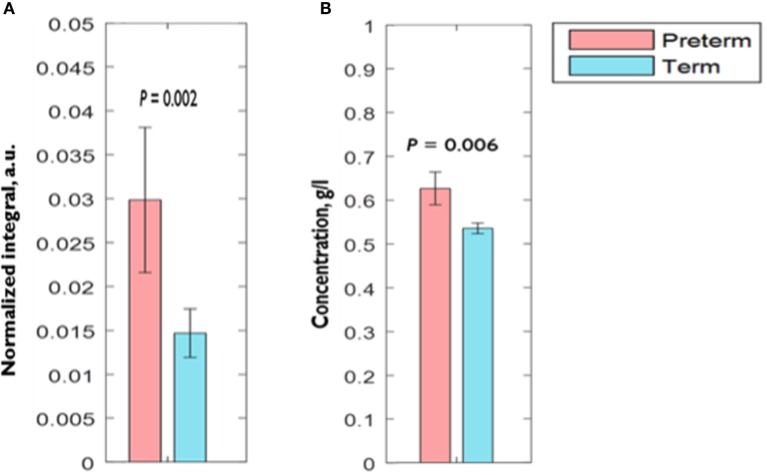
Comparison of CVF (A) acetate normalized integral measured by 1H-NMR (B) acetate concentration measured by spectrophotometry between preterm and term women. Error bars = SEM; a.u., arbitrary unit.